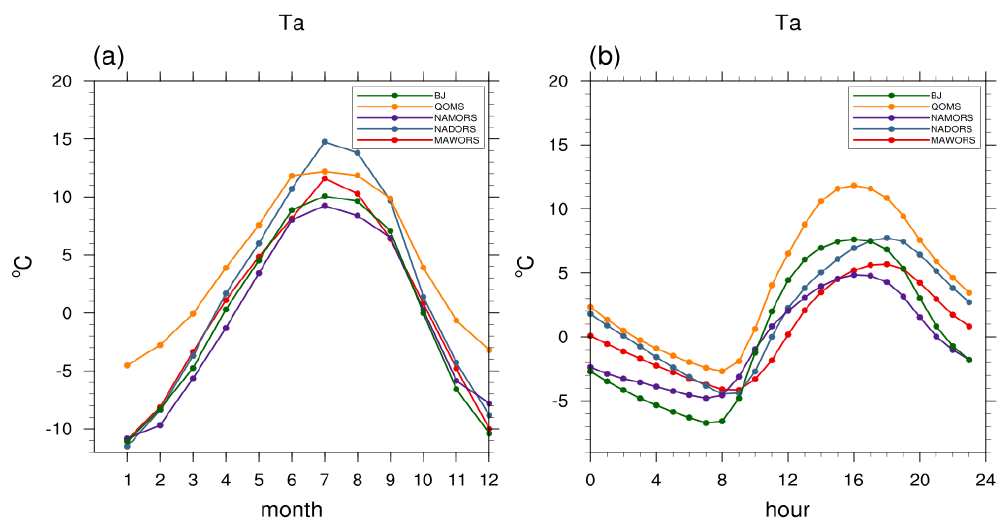
Figure 12. Annual variation of air temperature ( a ) and diurnal variation of air temperature ( b ) at each station.